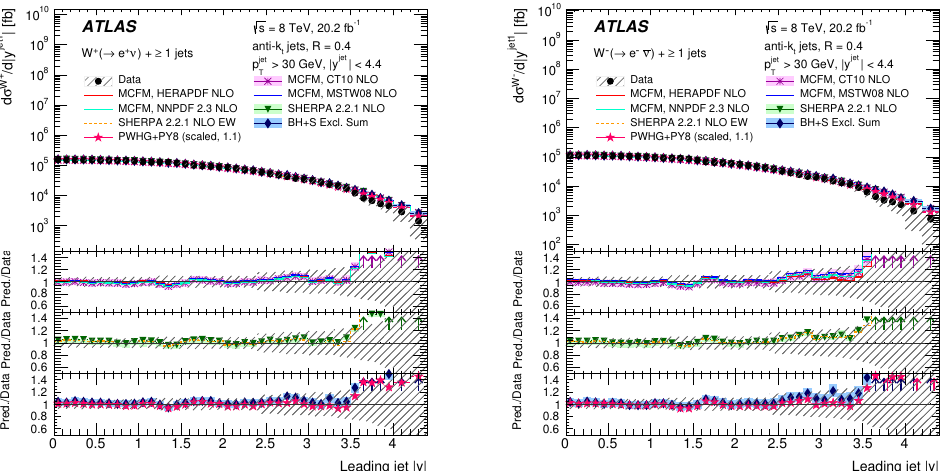
Figure 24 . Di(cid:11)erential cross sections for the production of W + (left) and W (cid:0) (right) as a function of the leading jet rapidity for events with N jets (cid:21) 1. For the data, the statistical uncertainties are indicated as vertical bars, and the combined statistical and systematic uncertainties are shown by the hatched bands. The uppermost panel in each plot shows the di(cid:11)erential cross sections, while the lower panels show the ratios of the predictions to the data. The theoretical uncertainties on the predictions are described in the text. The arrows on the lower panels indicate points that are outside the displayed range.